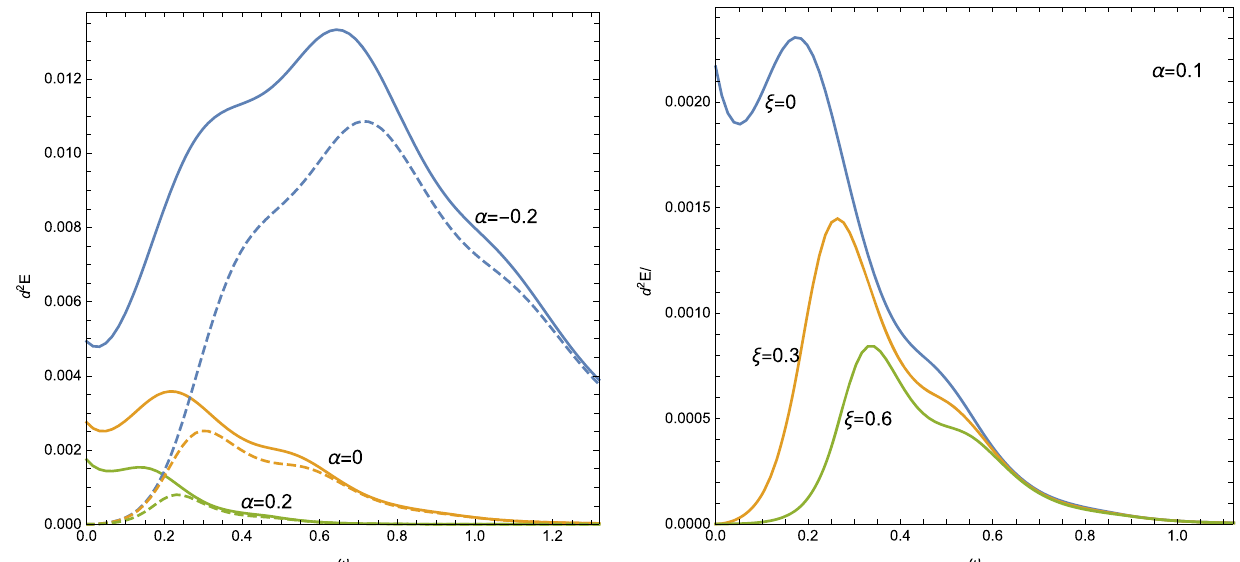
Fig. 6 The effects of α (left panel, solid lines for ξ = 0, dashed lines for ξ = 0 . 3) and ξ (right panel, with fixed α = 0 . 1) on the power spectra of Hawking radiation